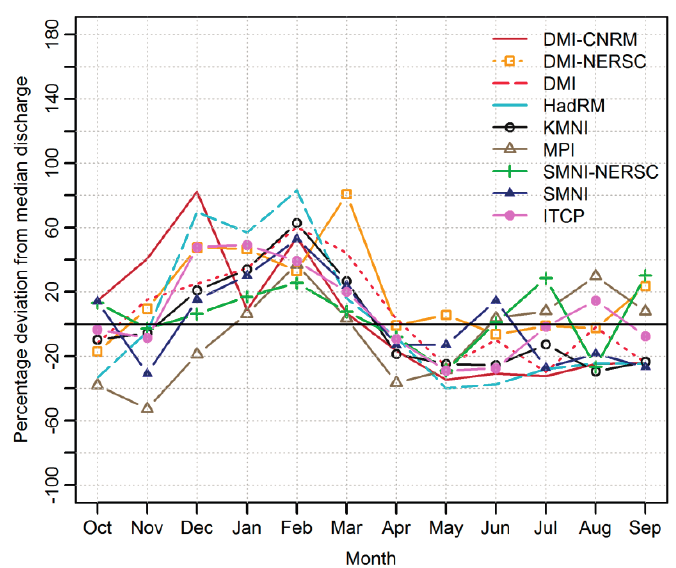
Figure 5. Deviation in monthly median discharge of Mures River for 2021–2050 [42].